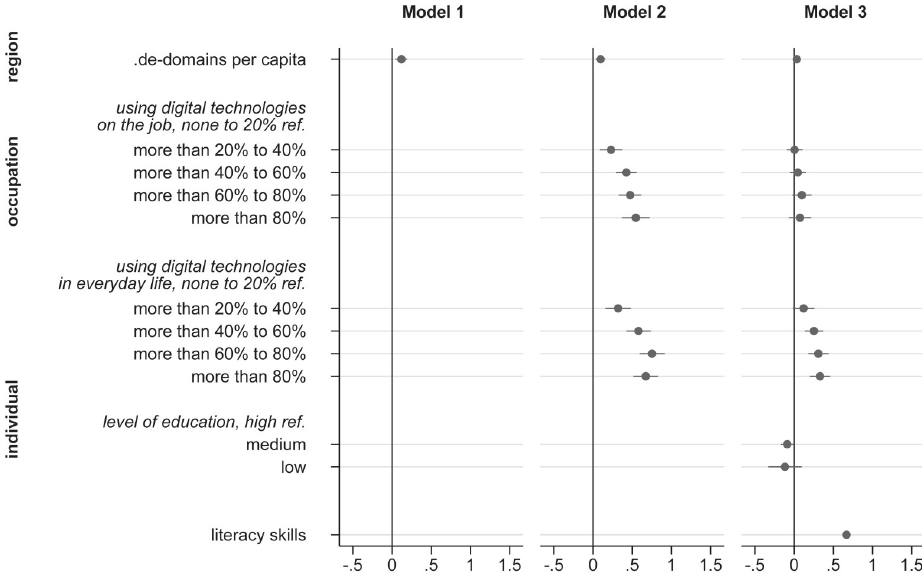
Fig 3. ICT skills regressed on individual and contextual factors (PIAAC). (A) Control variables: gender, age, migration. (B) Continuous variables standardized, cluster robust standard errors, 95% confidence intervals. (C) PIAAC Germany 2012, N(individuals) 2,495, N(regions) 245.